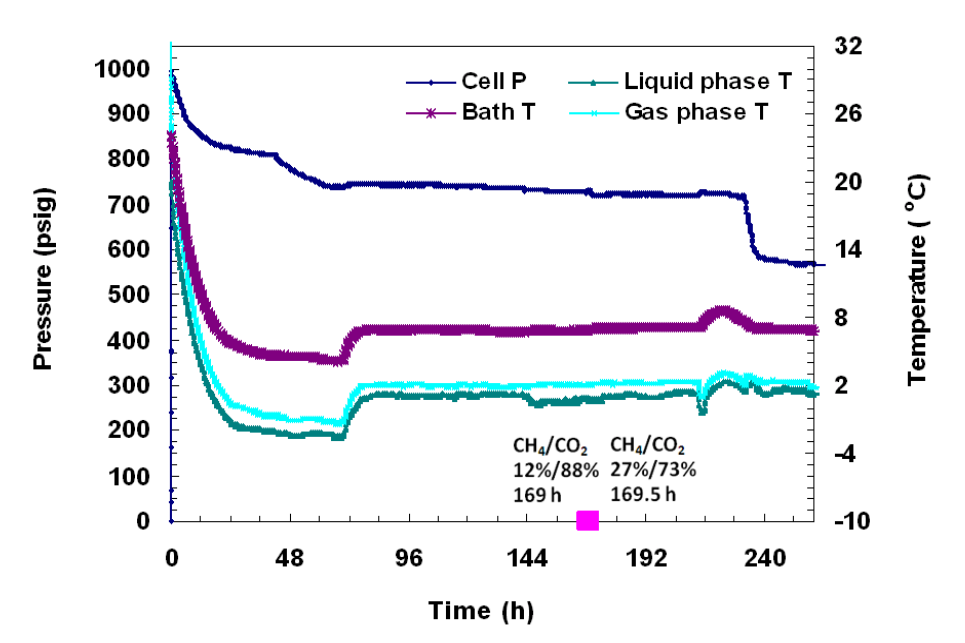
-CO mixture. The embedded pink dots 4 2